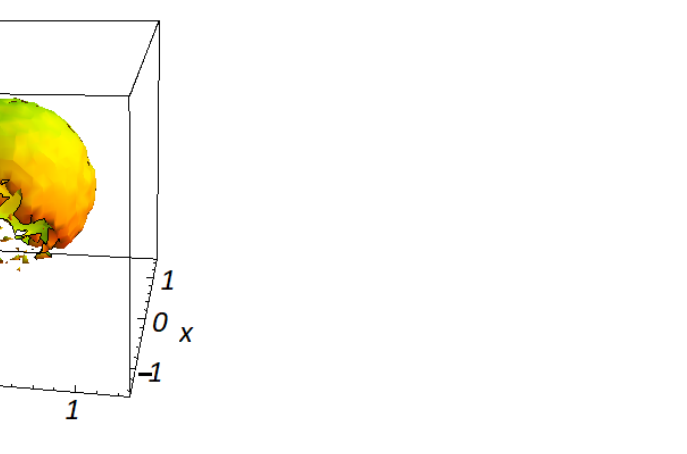
Figure 9. The reconstruction of the sphere of radius a = 1, in the framework of the backscattering ( 1,1,1 ) . The principal data are distributed over a surface element of measure case ˆ r 0 = − ˆ k = 1 √ 3 2 π ( 5 π ) 2 ( 1 − cos θ 29,1 ) and are supplemented with additional information over the dual cones of type K (cid:48) and K (cid:48)(cid:48)